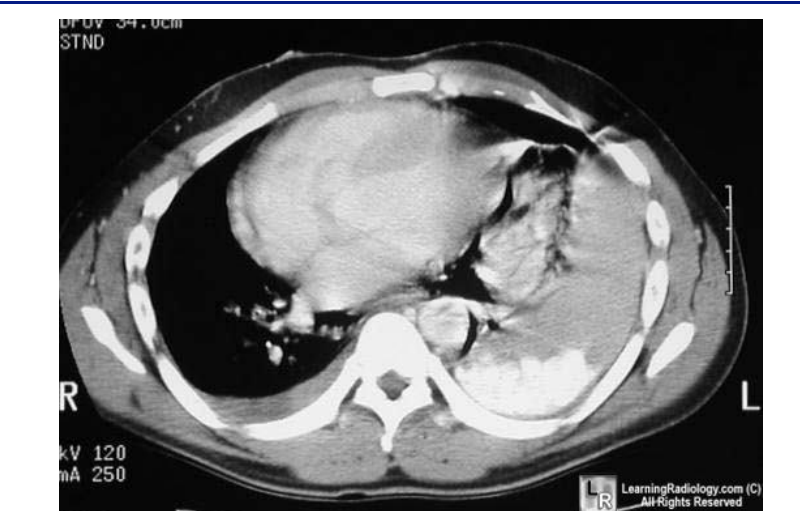
Figure 3. Mediastinal emphysema and extraluminal contrast in the left pleural cavity in patients with Boerhaave syndrome pneumomediastinum, pleural effusion (usually left-sided), mediastinal fluid collections, and emphysema in the chest wall and neck (Figure 3).